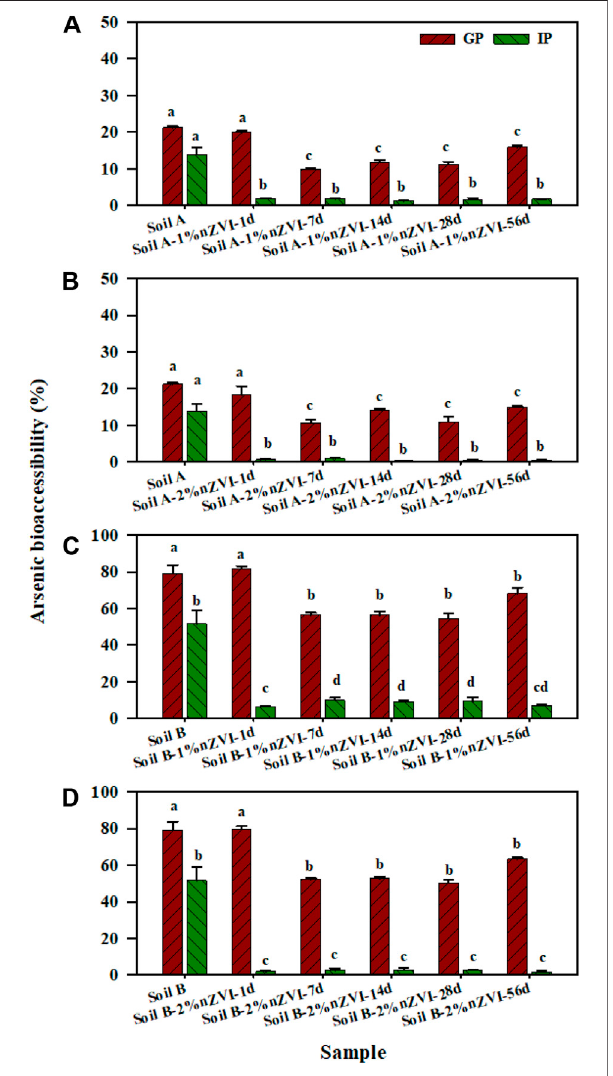
FIGURE 4 | Arsenic bioaccessibility in nZVI untreated and treated soil A (A,B) and B (C,D) samples measured by the gastric phase (GP) and intestinal phase (IP) of the SBRC. Data are expressed as mean and standard deviation of triplicates. Same letters above error bars demonstrate there was no signi fi cant difference between As bioaccessibility in GP or IP.